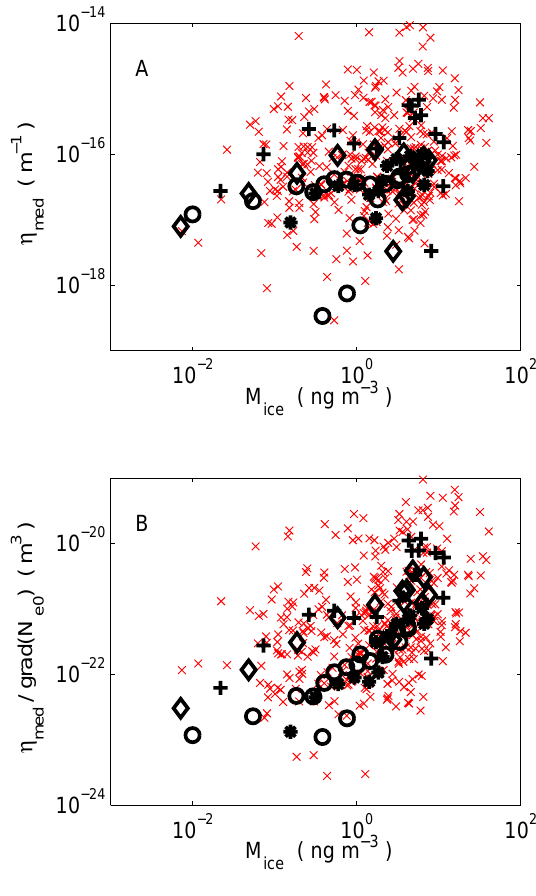
Fig. 4. Panel (A) scatter plot of volume reflectivity mea- sured by MARA against ice-mass density measured by SOFIE. Panel (B) scatter plot of volume reflectivity measured by MARA di- vided by model electron density gradient, against ice-mass density measured by SOFIE. Red crosses correspond to average values for individiual days of observations. Black symbols correspond to av- erages over several days, ◦ from 16 days before solstice to solstice, ∗ from 1–15 days after solstice, + from 16–25 days after solstice, ♦ from 17–38 days after solstice. Only observations during quies- cent conditions (Ap < 15) are included. Note that zeroes (observa- tions when PMSE or ice density are below the respective detection thresholds) cannot be plotted on the logarithmic scales used in this figure, but they are included in average